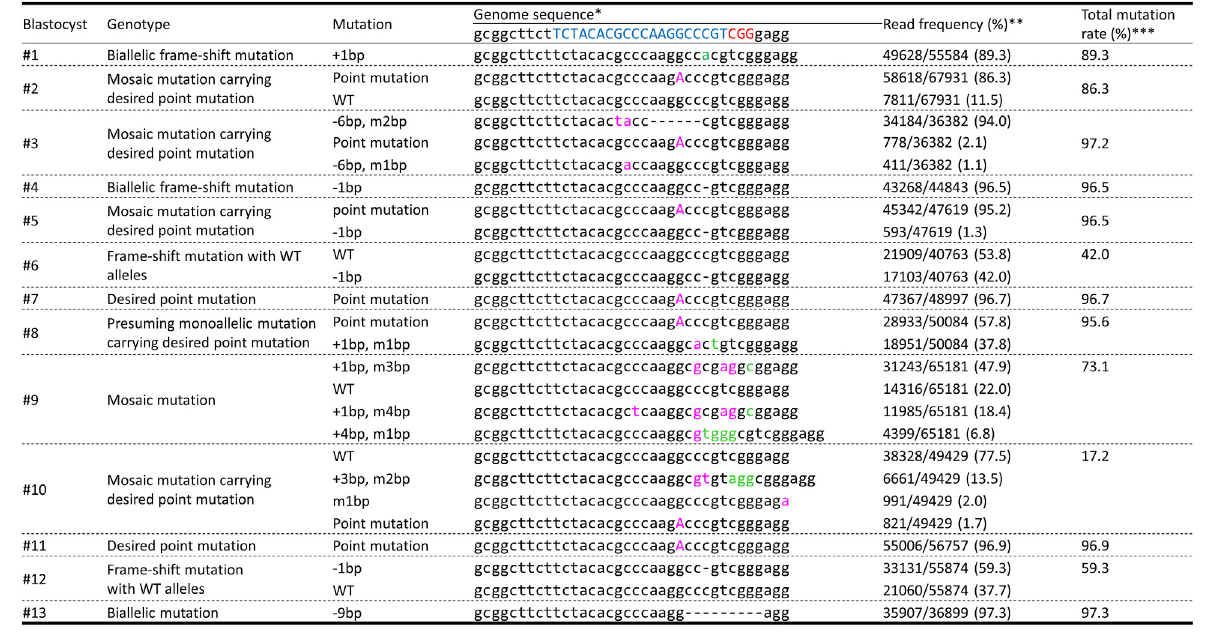
FIGURE 4 Deep-sequencing analysis of the INS target regions in blastocysts obtained using the same procedure adopted to generate genetically modi fi ed pigs carrying point mutations. * The target and PAM sequences of gRNA are indicated in blue and red, respectively. Inserted and modi fi ed sequences are represented by green and pink, respectively. ** The frequency was calculated by dividing the number of amplicons by the total number of reads. *** The mutation rate was calculated by dividing the total number of mutant amplicons by the total number of reads.